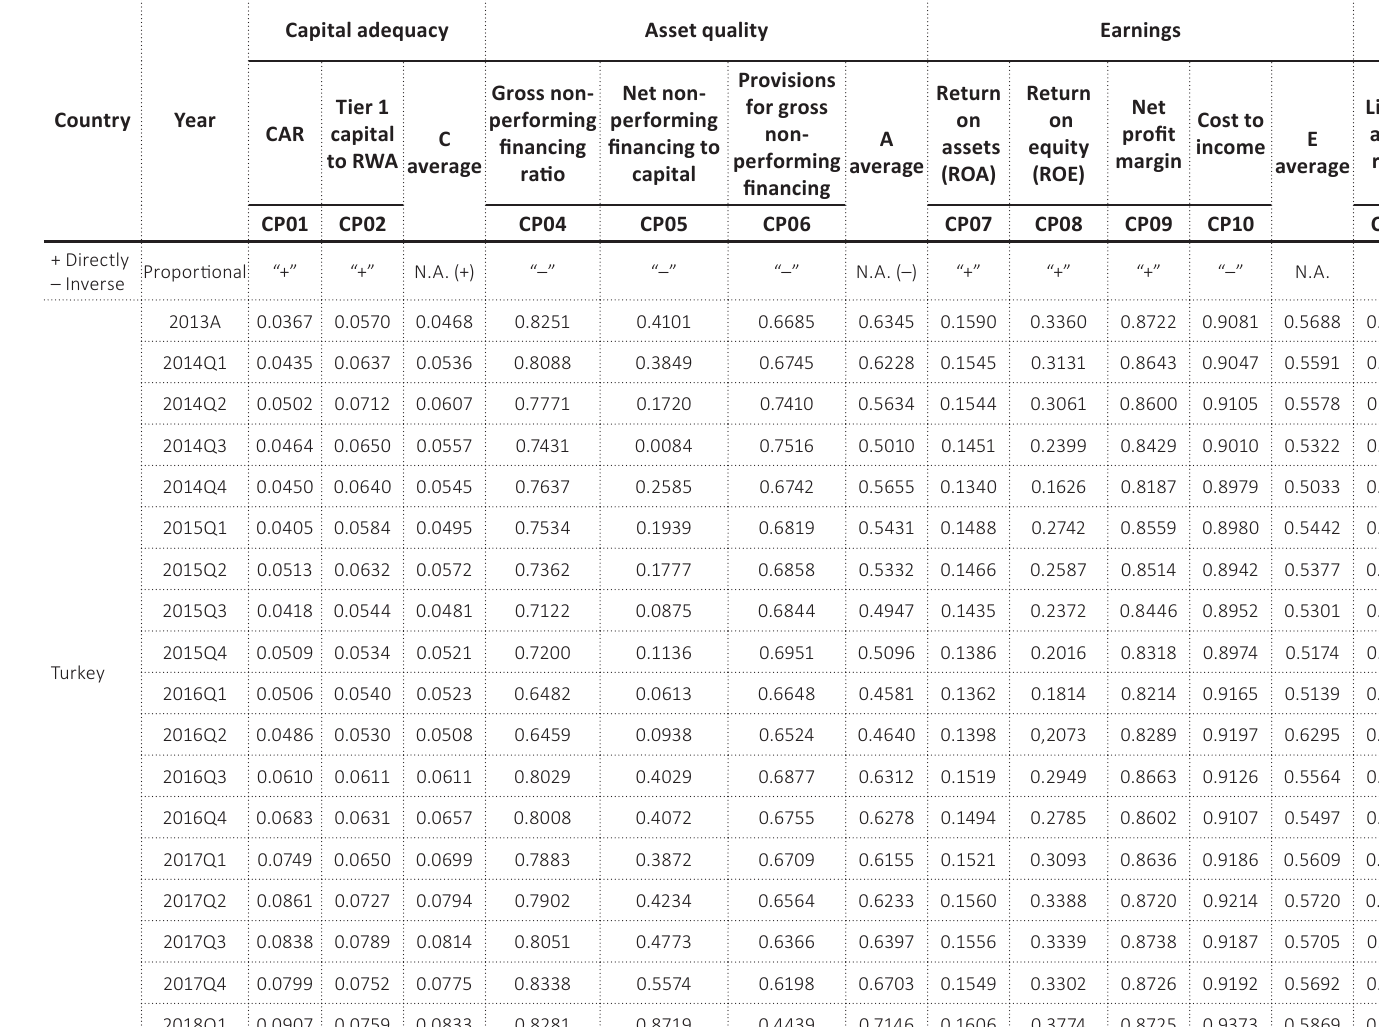
Source: Own calculation based on IFSB